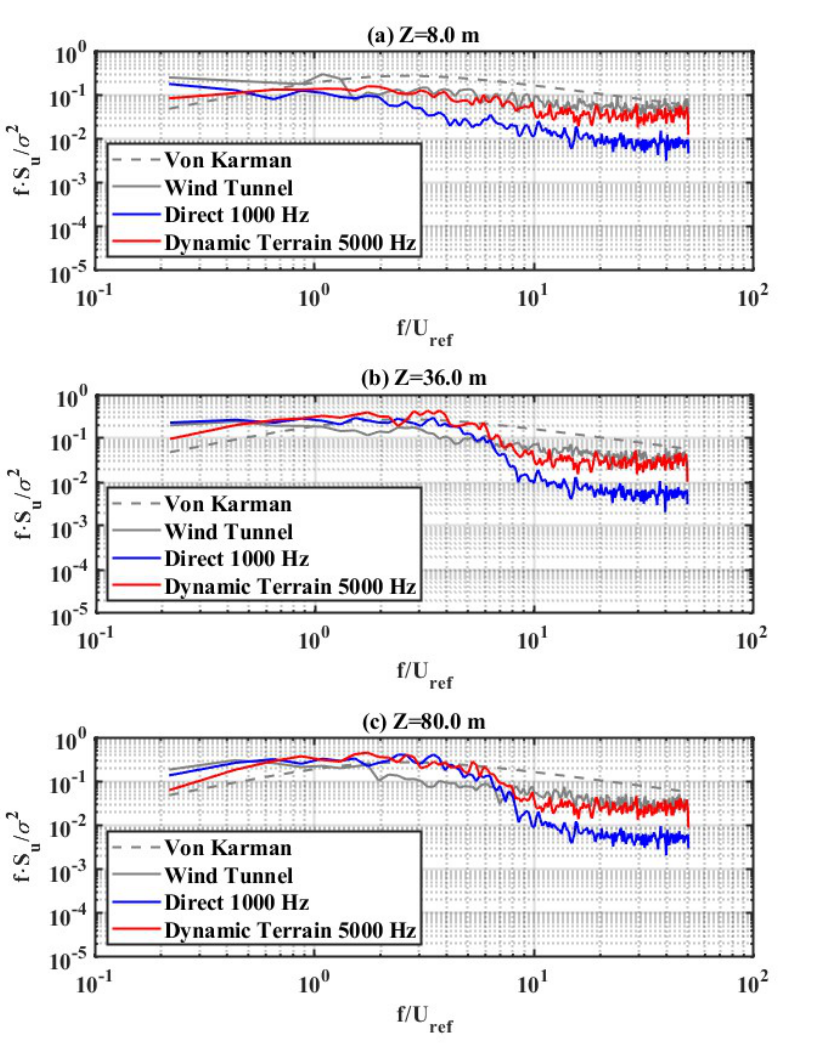
Figure 14. Spectrum of longitudinal velocity from von Karman, as extracted from wind tunnel and calculated from dynamic terrain 5000 Hz and direct method at